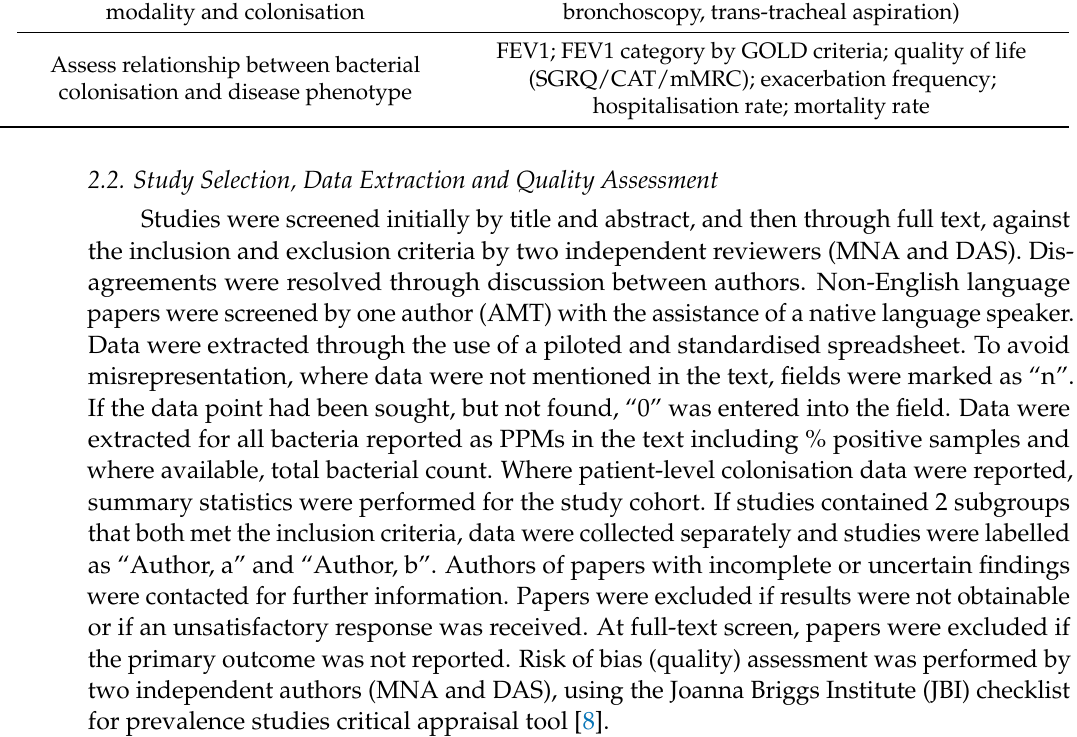
Number of patients that produced a sample; number of samples collected; number of positive cultures;